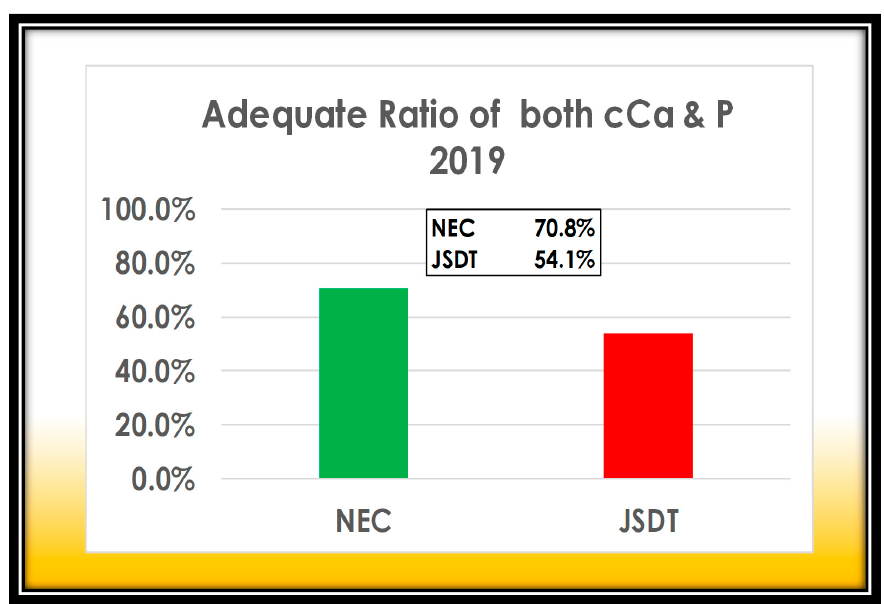
Figure 7. Simultaneous adequate range ratio of P and cCa in our cases comparing to JSDT. Our result is 16.7% superior to 54.1% of JSDT WADDA. NEC; Nijo Ekimae Clinic. P-binders are administered in 52% of patients with sucroferric oxyhydroxide and 40% with lanthanum carbonate hydrate. Precipitated calcium carbonate is prescribed